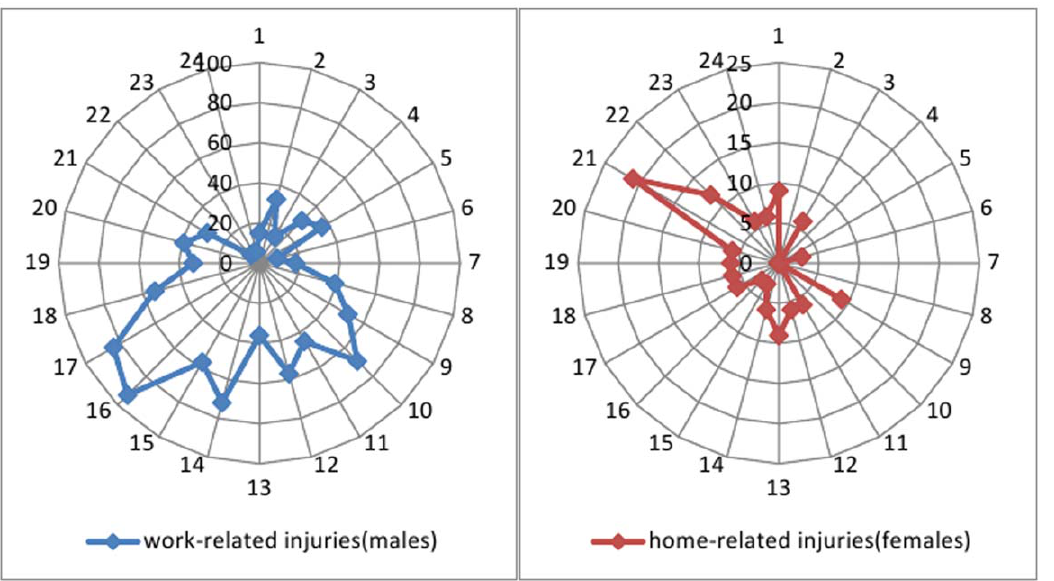
Figure 2. Incidence times of work-related and home-related eye injuries in males and females, respectively, plotted over a one-day period. Work-related eye injuries in males were spread throughout the day and night, with most injuries occurring during 16:00–17:00 (12.3%); home-related injuries in females primarily occurred during 21:00–22:00 (16.4%). The radial numbers are a count of patients for the entire 10-year period and the circumferential numbers are the hours of the day.